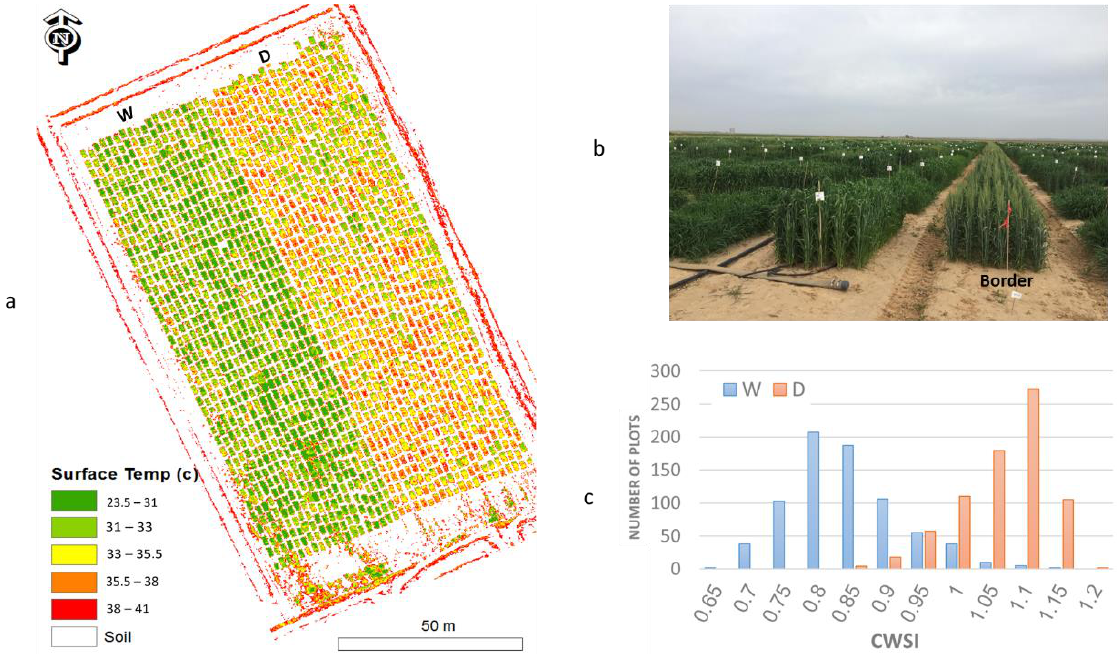
Figure 2. ( a ) Surface temperature map of the experimental field consisting of well – watered (W), and water-limited (D) treatments; ( b ) Experimental field, where the border between two water regimes is marked with red flag; ( c ) Distribution of crop water stress index (CWSI) within the two treatments.